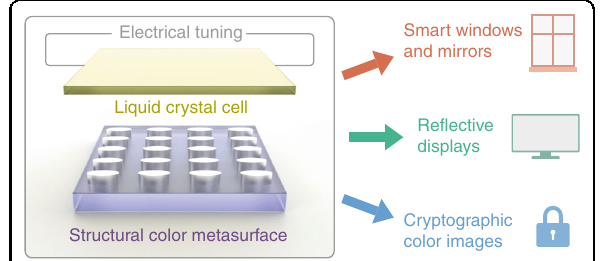
Fig. 1 Electrically tunable structural color metasurfaces enable a multitude of